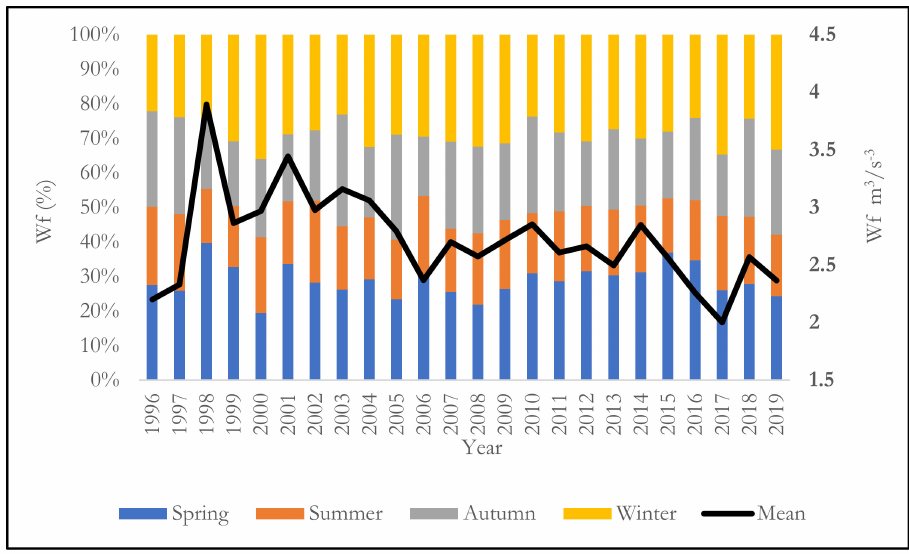
Figure 9. Seasonal and temporal variability of Wf .